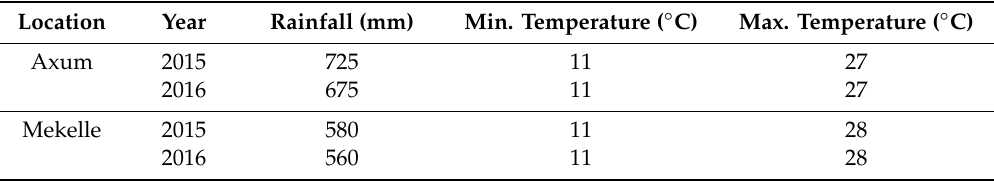
Table 1. Rainfall, minimum temperature, and maximum temperature in Axum and Mekelle during 2015 and 2016. Location Year Rainfall (mm) Min. Temperature ( ◦ C) Max. Temperature ( ◦ C) Axum 2015 725 11 27 2016